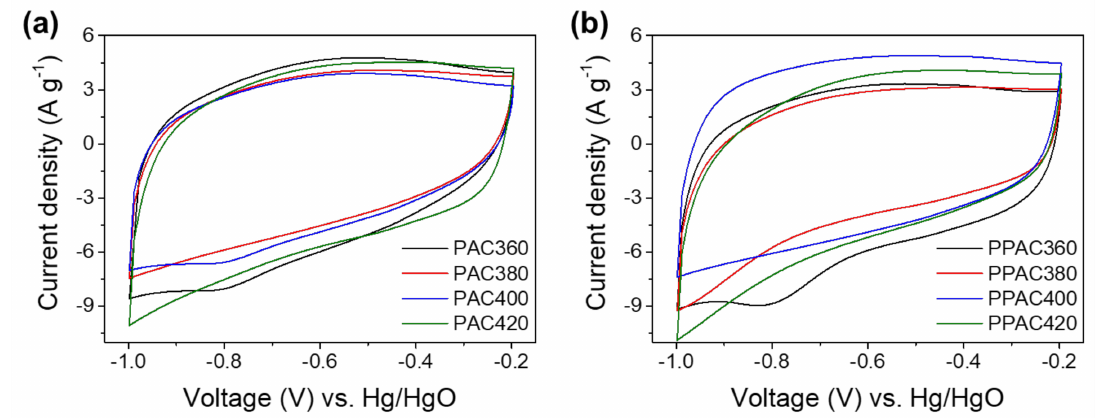
Figure 1. CV curves of EDLC fabricated with electrodes based on ( a ) PAC and ( b ) PPAC prepared by various pitch